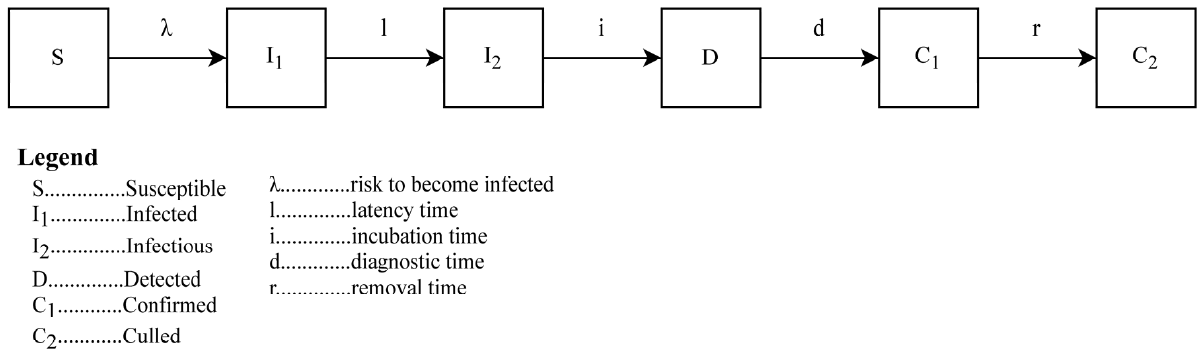
Figure 2. SI 1 I 2 DC 1 C 2 model. Table 2. Model parameters and their values selected as defaults in the